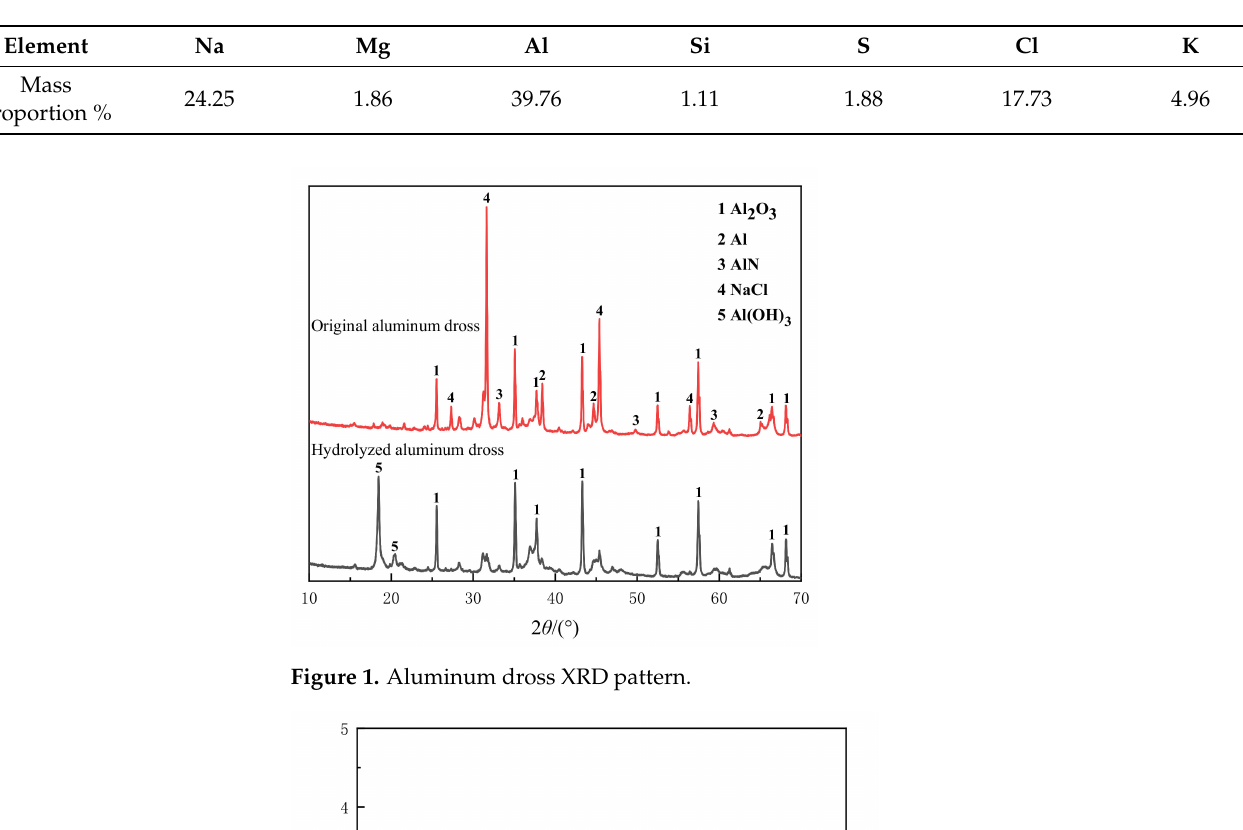
Table 1. Aluminum dross XRF.